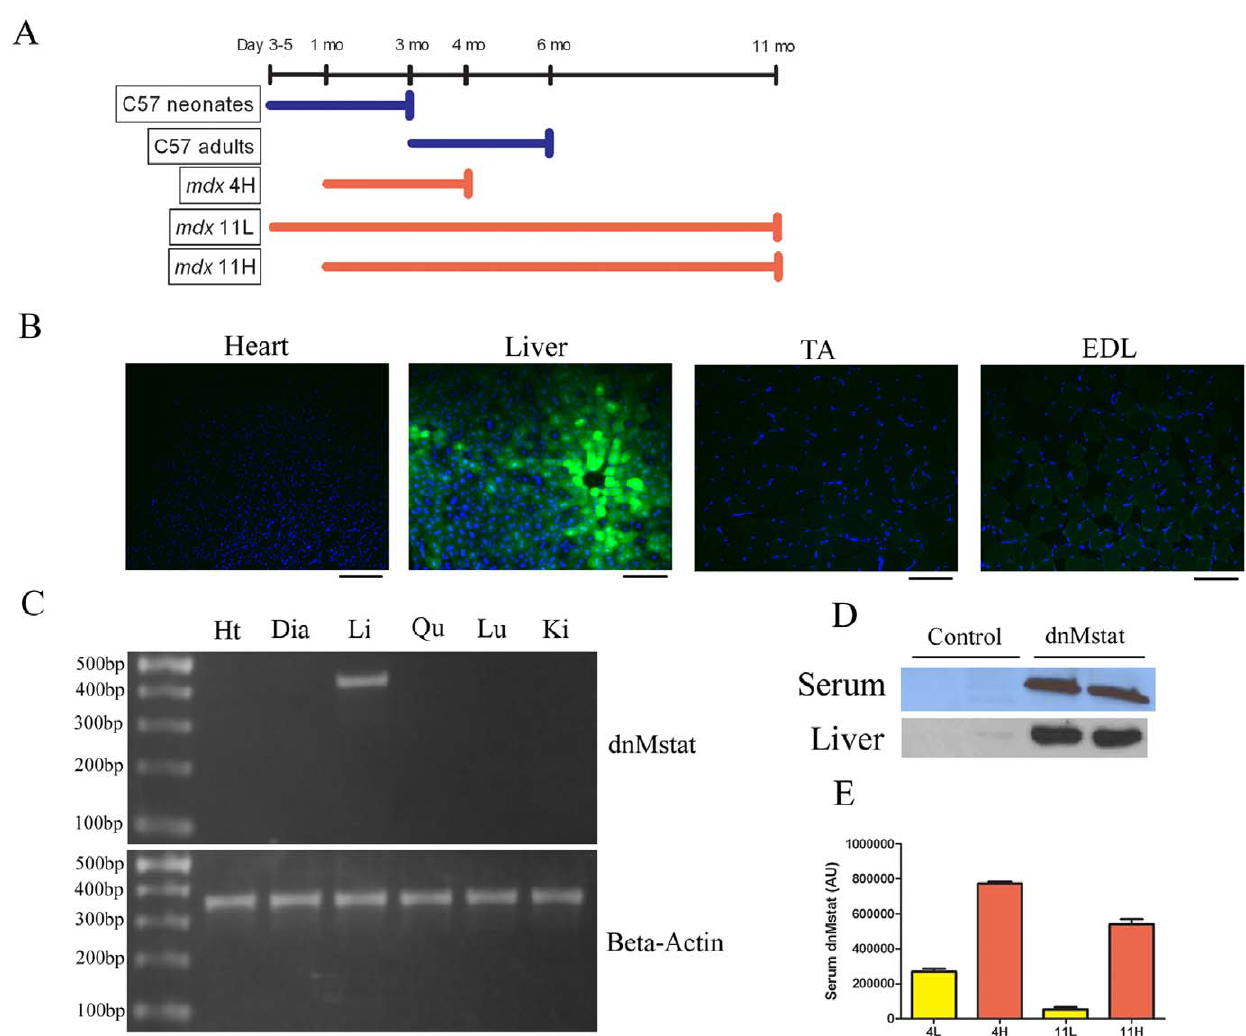
Figure 1. Systemic viral delivery and dnMstat expression. The viral construct used in all experiments consists of a liver specific promoter (LSP) paired with dominant negative myostatin (dnMstat). A similar construct was prepared by substituting GFP for dnMstat. (a) Experimental design for C57 Bl/6 and mdx groups injected intravenously with AAV 2/8 LSP.dnMstat. The C57 neonates group was injected at day 3–5 of life and sacrificed at three months of age while the C57 adults group was injected at three months of age and sacrificed at six months of age. The mdx 4H group was injected at one month of age and sacrificed at four months of age. The mdx 11L and 11H groups were sacrificed at eleven months of age and injected as neonates (11L) or at one month of age (11H). AAV 2/8 LSP.GFP or AAV 2/8 LSP.dnMstat was injected into the tailvein of adult C57 Bl/6 mice to assess the specificity of the promoter and to confirm overexpression of dnMstat. (b) Following injection of AAV 2/8 LSP.GFP, GFP fluorescence was only observed in the liver. (c) Tissue specificity of transgene expression was further assessed by RT-PCR following injection of AAV 2/8 LSP.dnMstat. RNA was isolated from treated heart (Ht), liver (Li), diaphragm (Dia), quadriceps (Qu), lung (Lu) and kidney (Ki), treated with DNase to remove residual AAV vector genomes and reverse transcribed. PCR was performed on the resulting cDNA to assess the expression of dnMstat ( , 450 bp) and beta- actin as a control ( , 350 bp). Transgene expression was detected solely in the liver. (d) dnMstat was detected in the serum and liver by immunoblotting with an antibody directed against the myostatin N-terminus. (e) Serum levels of dnMstat were measured at the experimental endpoints. Circulating levels of the inhibitor were approximately three times higher in the mdx 4H group than the mdx 4L group. The absolute difference in expression level was maintained at eleven months of age in the 11L and 11H groups. Note that the mdx 4L group was not